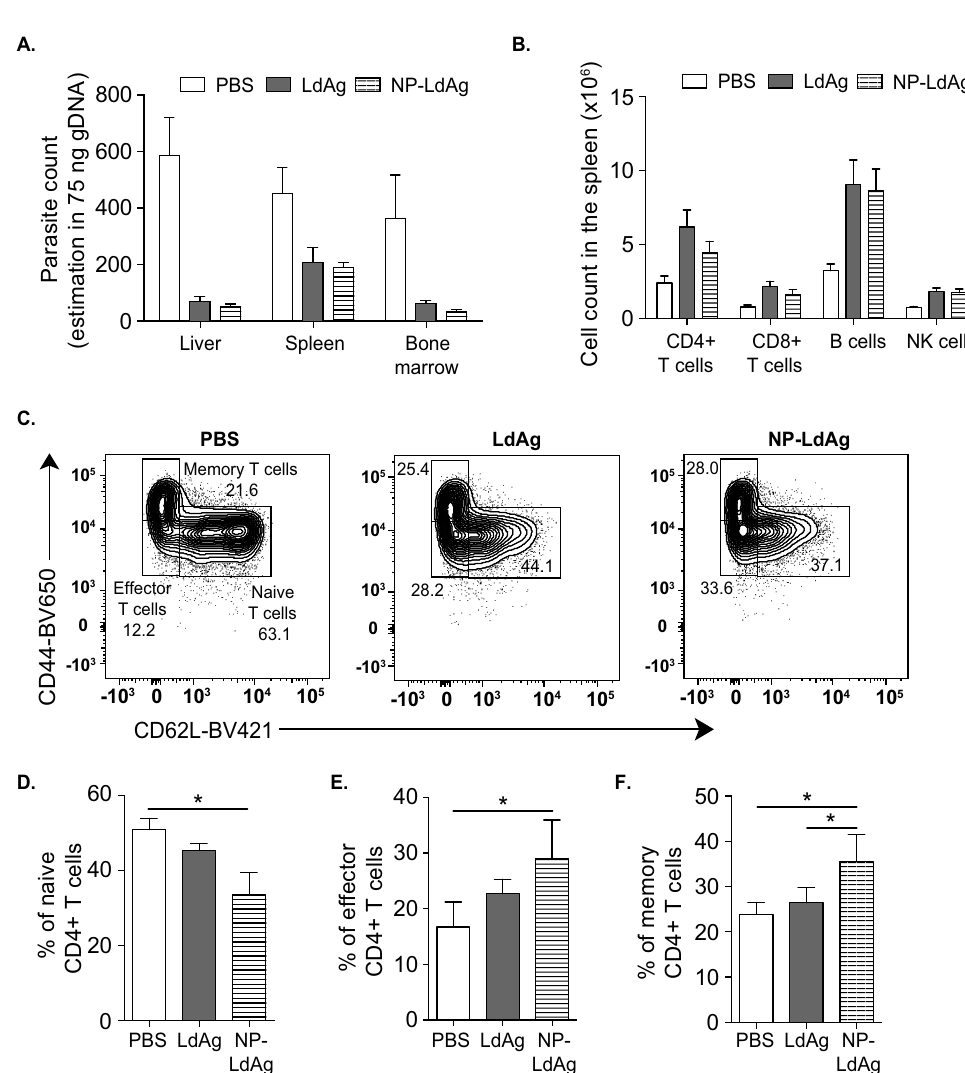
Fig 6. NP-LdAg formulation increases the percentage of effector and memory CD4+ T cells. (A) The effect of LdAg or NP-LdAg immunization on L . donovani parasite count in livers, spleens and bone marrows estimated by qPCR in 75 ng of tissue gDNA. (B) Impact of LdAg or NP-LdAg vaccination on the number of CD4+ T cells, CD8+ T cells, B cells and NK cells, assessed by flow cytometry using count beads. (C) Cytometry plots representing na ï ve, effector and memory CD4+ T cells in the spleen identified using CD62L and CD44 staining. (D-F) Percentage of na ï ve (D), effector (E) and memory CD4+ T cells in the spleen. Data are representative of two independent experiments and are presented as means ± SEM ( n = 5–7; one-way